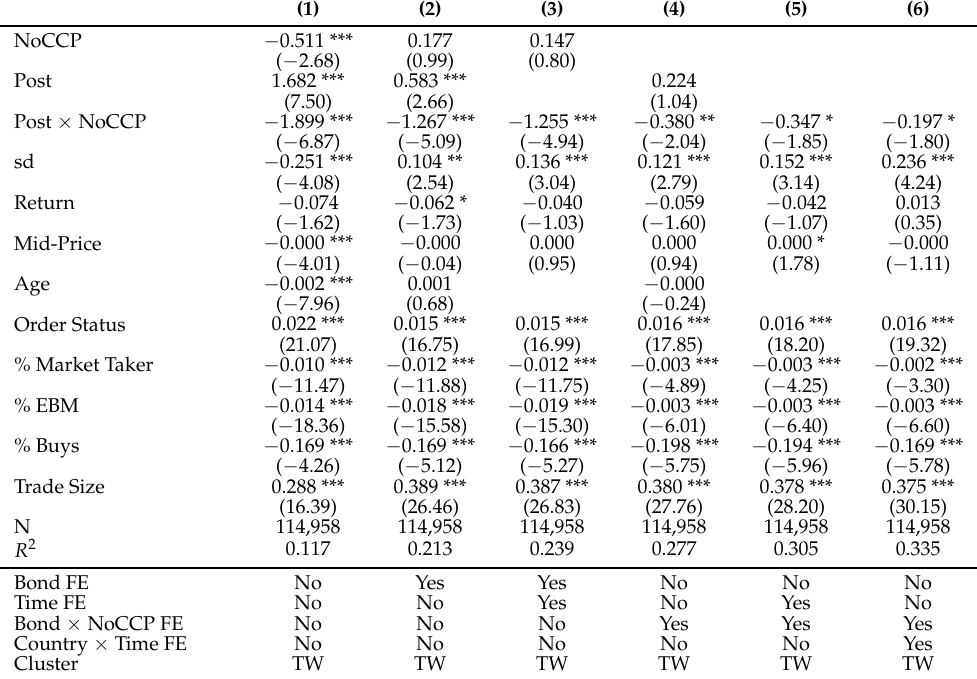
Table 6. Difference-in-difference with number of bonds